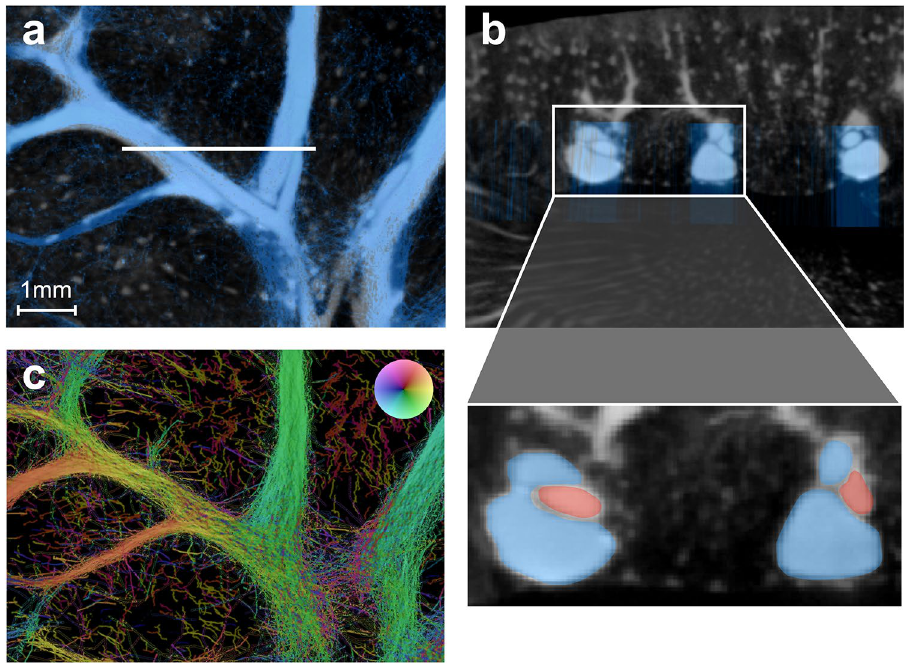
Figure 4. Veins wrapped around their paired artery. ( a ) Section of a coronal image slice of the μ CT with overlap of super-resolution ultrasound scan 2 (blue). ( b ) Section of a sagittal image slice of the μ CT with overlap of super-resolution ultrasound scan 2 (blue). The up-scaled content shows how the large segmental veins (blue) wrap around their paired segmental artery (red). ( c ) Unfiltered microbubble track map of the same slice as ( a ) (for visualization, the color transparency in the microbubble track map is scaled by the intensity map). The arteries are not readily apparent in the microbubble track maps without filtering and separating the microbubbles with artery and vein flow direction, as shown in Fig. 3b-2.